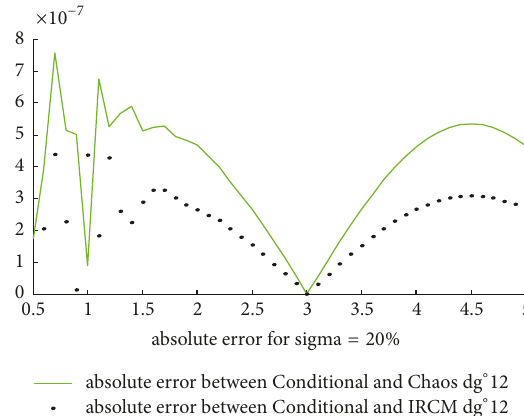
Figure 8: Absolute error between PC of degree 12 and IRCM of degree 12 and reference methods where 𝜉 0 and 𝜉 2 are truncated normal variables in [−4,4] , 𝜉 1 is a uniform variable in [−1, 1] and 𝜉 3 is a truncated exponential variable in [0,10] and 𝜎 𝑖 = 20%.